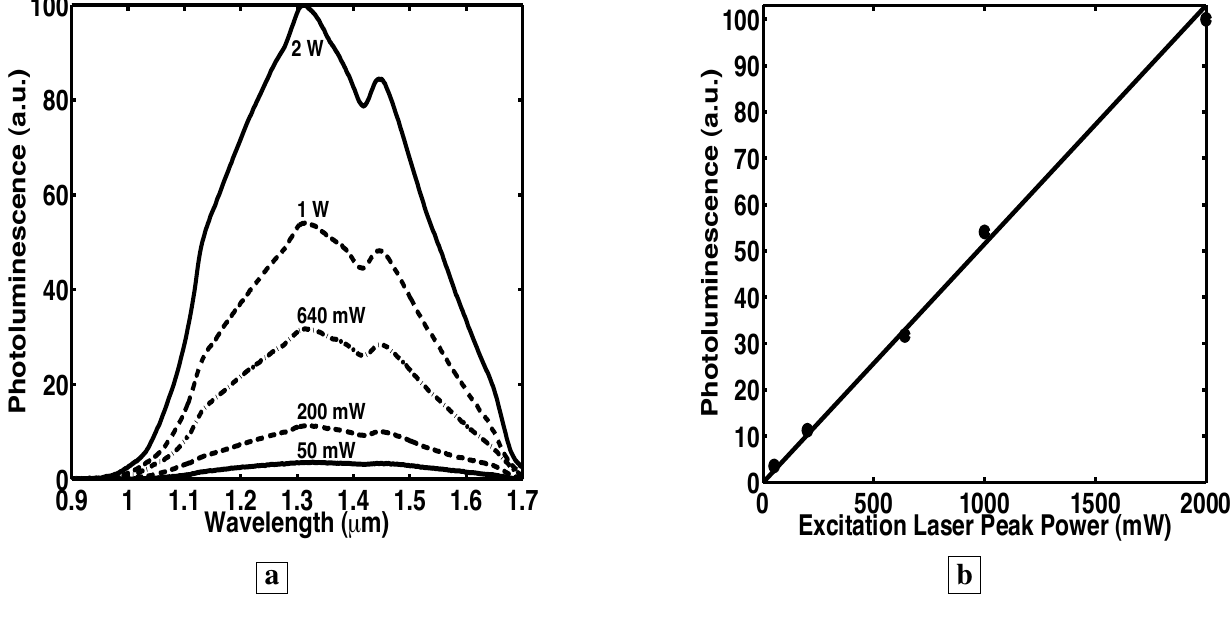
Figure 4 . Room temperature PL [7] as a function of the optical pump power. a, The room temperature PL retains its spectral shape for all excitation laser peak powers up to 2 W. b, The PL peak at 1.31 µ m as a function of the excitation laser peak power.